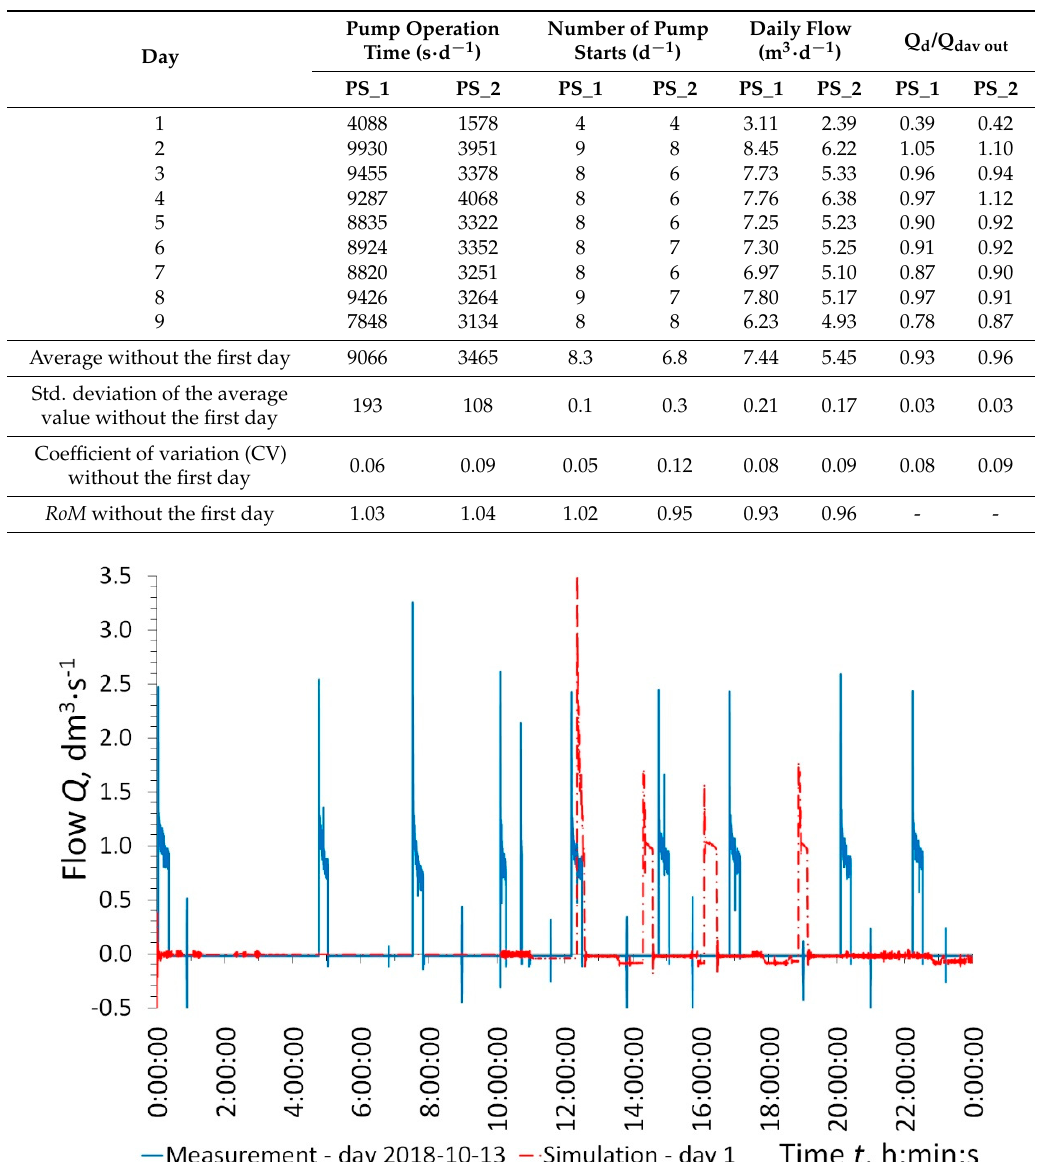
Table 4. Simulated pumping station’s operational characteristics.